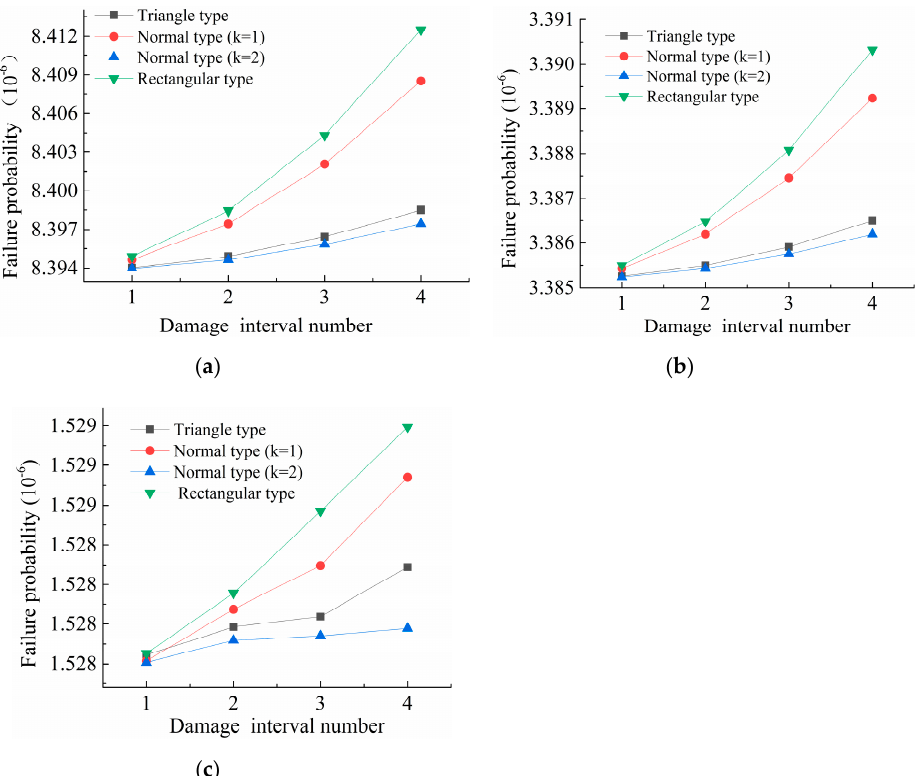
Figure 6. System reliability considering fuzzy detection information of the hinge joint damage degree and member failure credibility: ( a ) failure criterion I; ( b ) failure criterion II; ( c ) failure criterion Ш